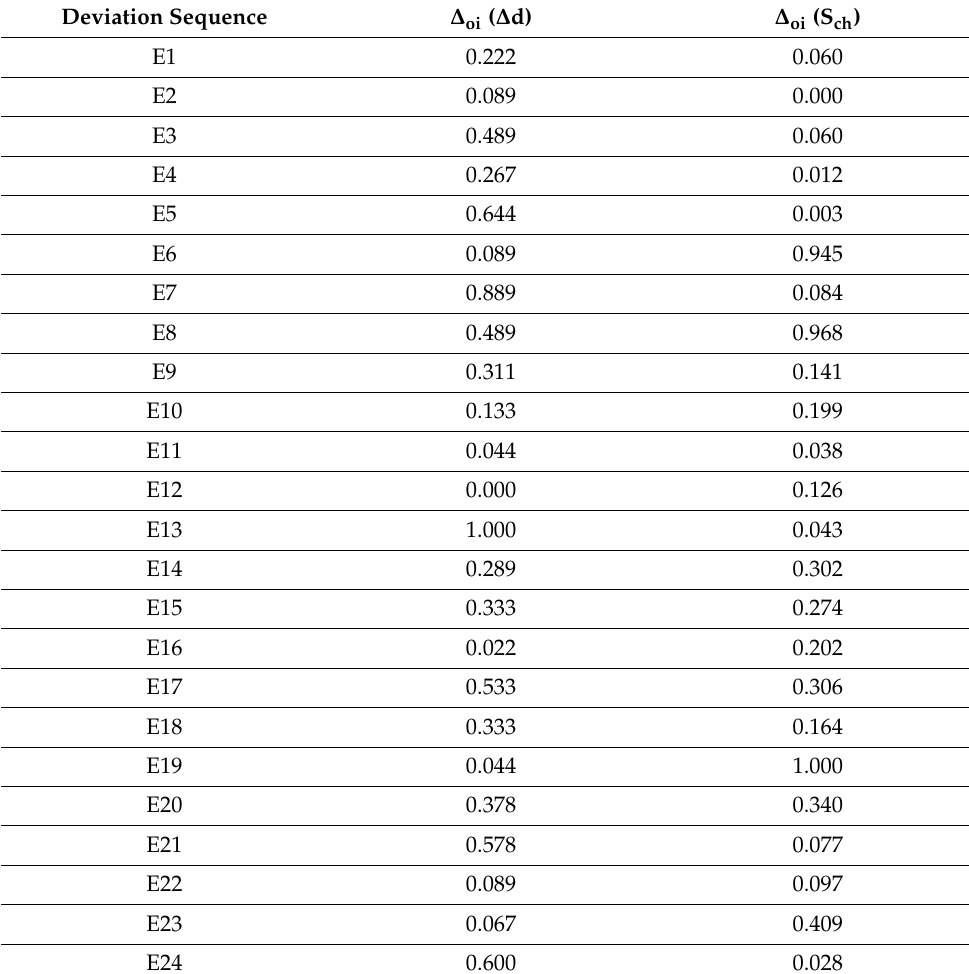
Table 7. The deviation